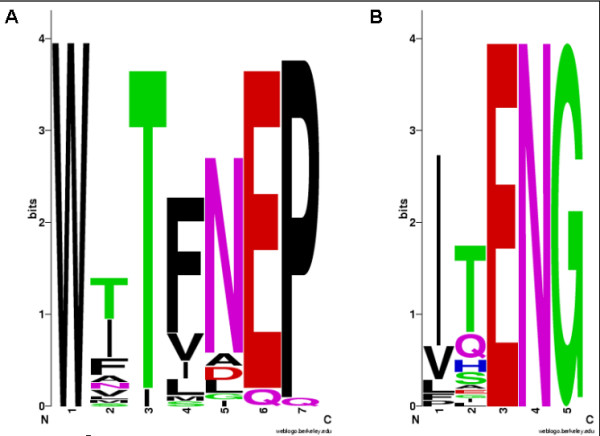
Sequence Logos for the residues surrounding the catalytic acid/base (A) and catalytic nucleophile (B) in rice GH1 genes. The logos show the size of the different amino acids at each position in proportion to their relative abundance within the 40 rice Glycosyl Hydrolase 1 gene protein sequences. The logos were drawn with the weblogo facility [73].